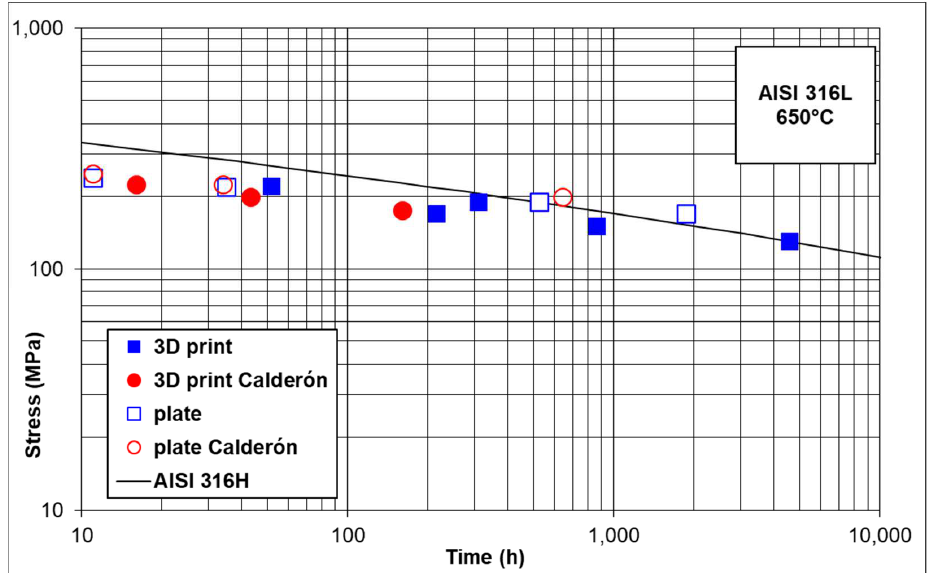
Figure 17. Comparison of stress–time to rupture dependence for 3D-printed and hot-rolled steel AISI 316L, lines represent mean CRS of AISI 316H steel at 650 °C.